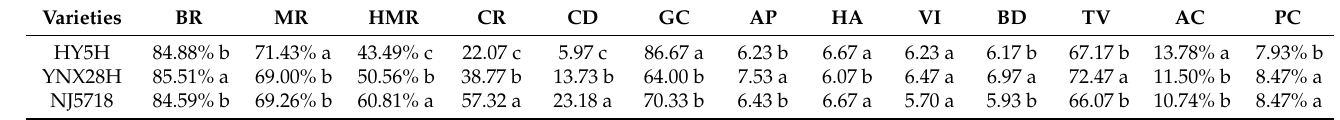
Table 1. Analysis of differences in the quality traits of three semi-glutinous japonica rice varieties. Varieties BR MR